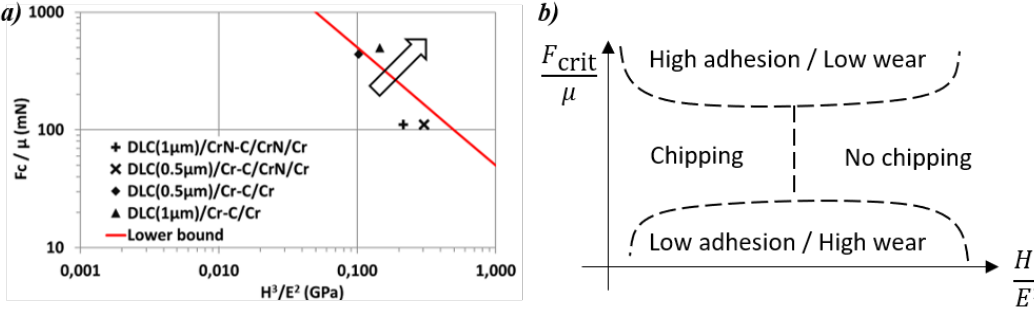
Figure 7. a) Material property map and b) failure mechanism map for DLC multilayer